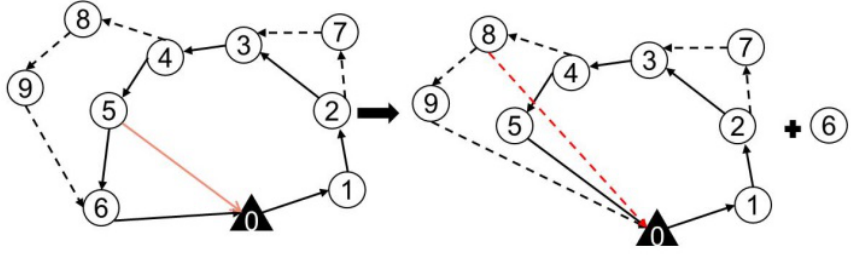
Figure 6. Schematic diagram of the maximum savings destroy